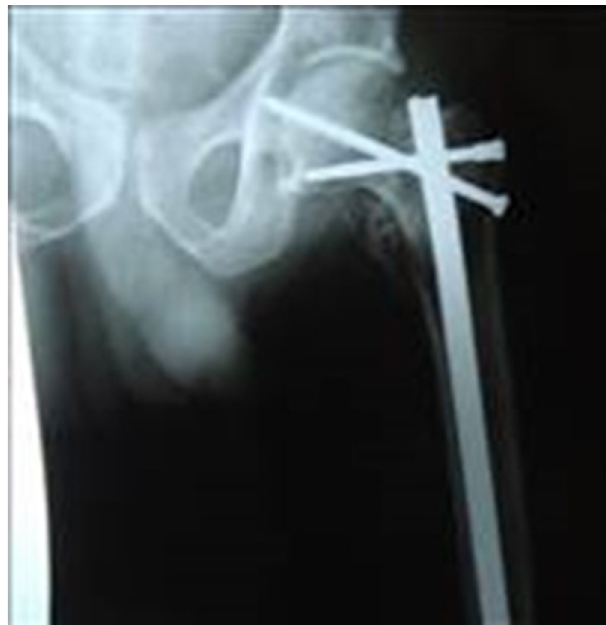
Figure 4. Intra-articular screw